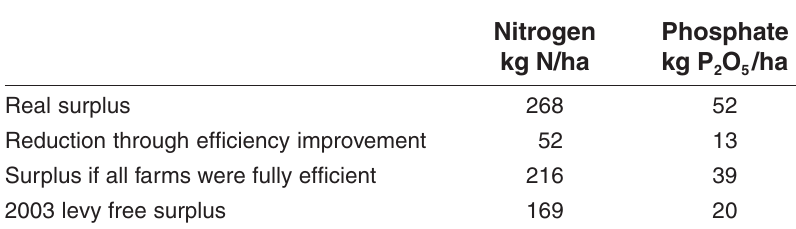
3-Year Averages of Reduction Possibilities Through Efficiency Improvement for Nitrogen and